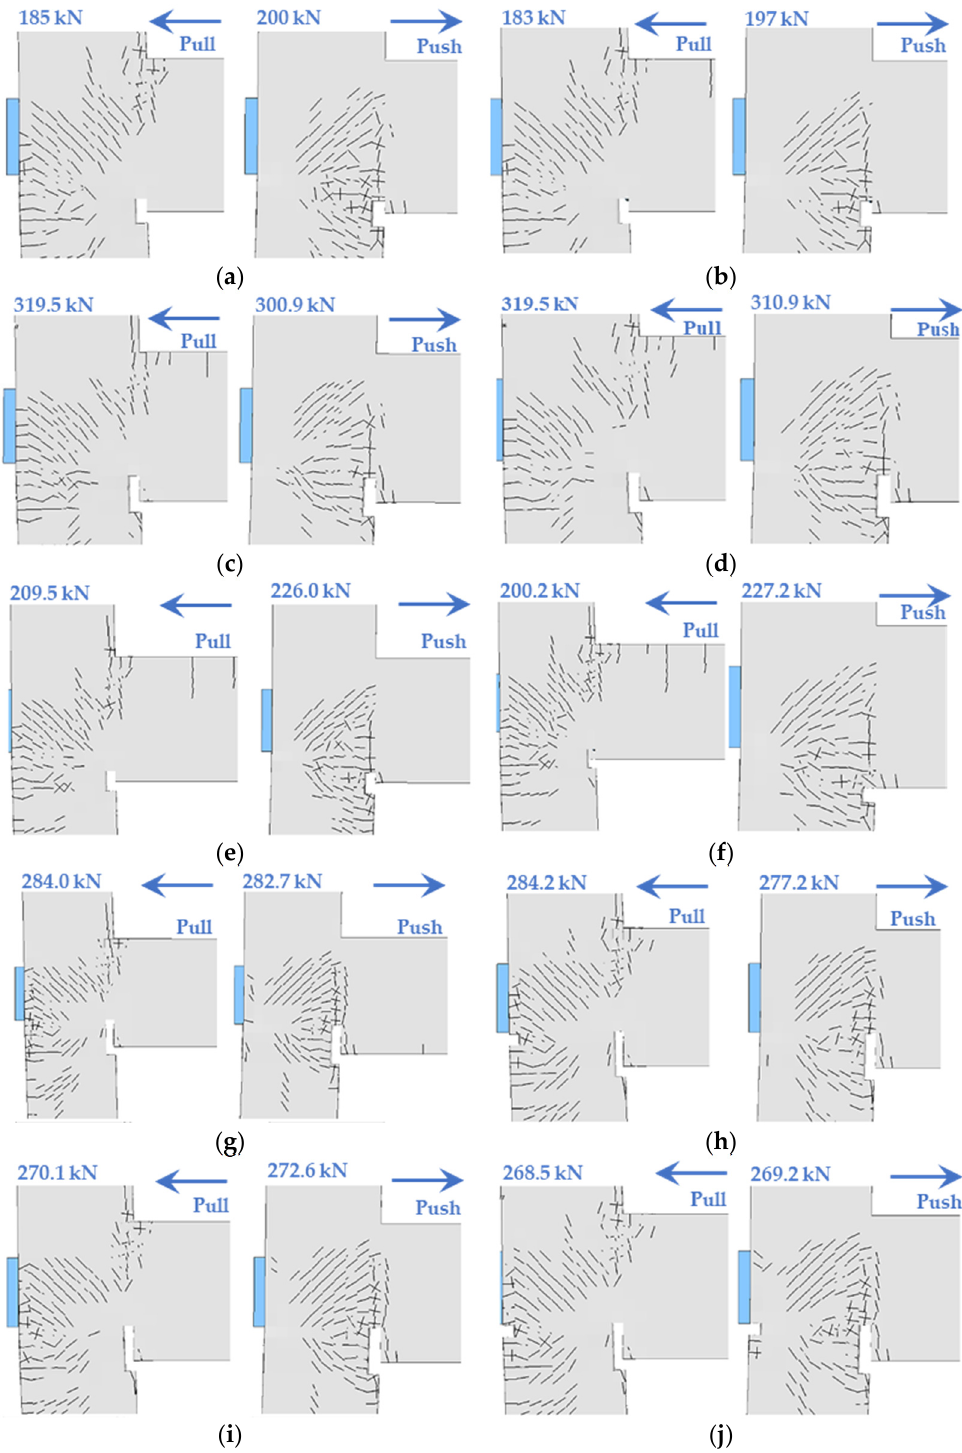
Figure 18. Crack and failure patterns of frame models: ( a ) H-C25; ( b ) L-C25; ( c ) HI-C40; ( d ) LI-C40; ( e ) H-C40; ( f ) L-C40; ( g ) HSQ-C25-T8; ( h ) LSQ-C25-T8; ( i ) HSQ-C25-T6; ( j ) LSQ-C25-T6.